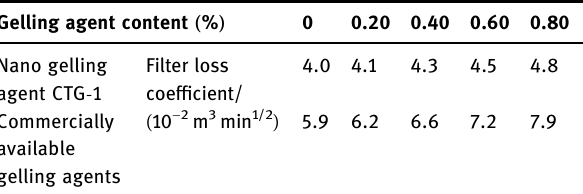
Table 1: E ff ect of gelling agent content on acid fl uid loss coe ffi cient of carbonate rock